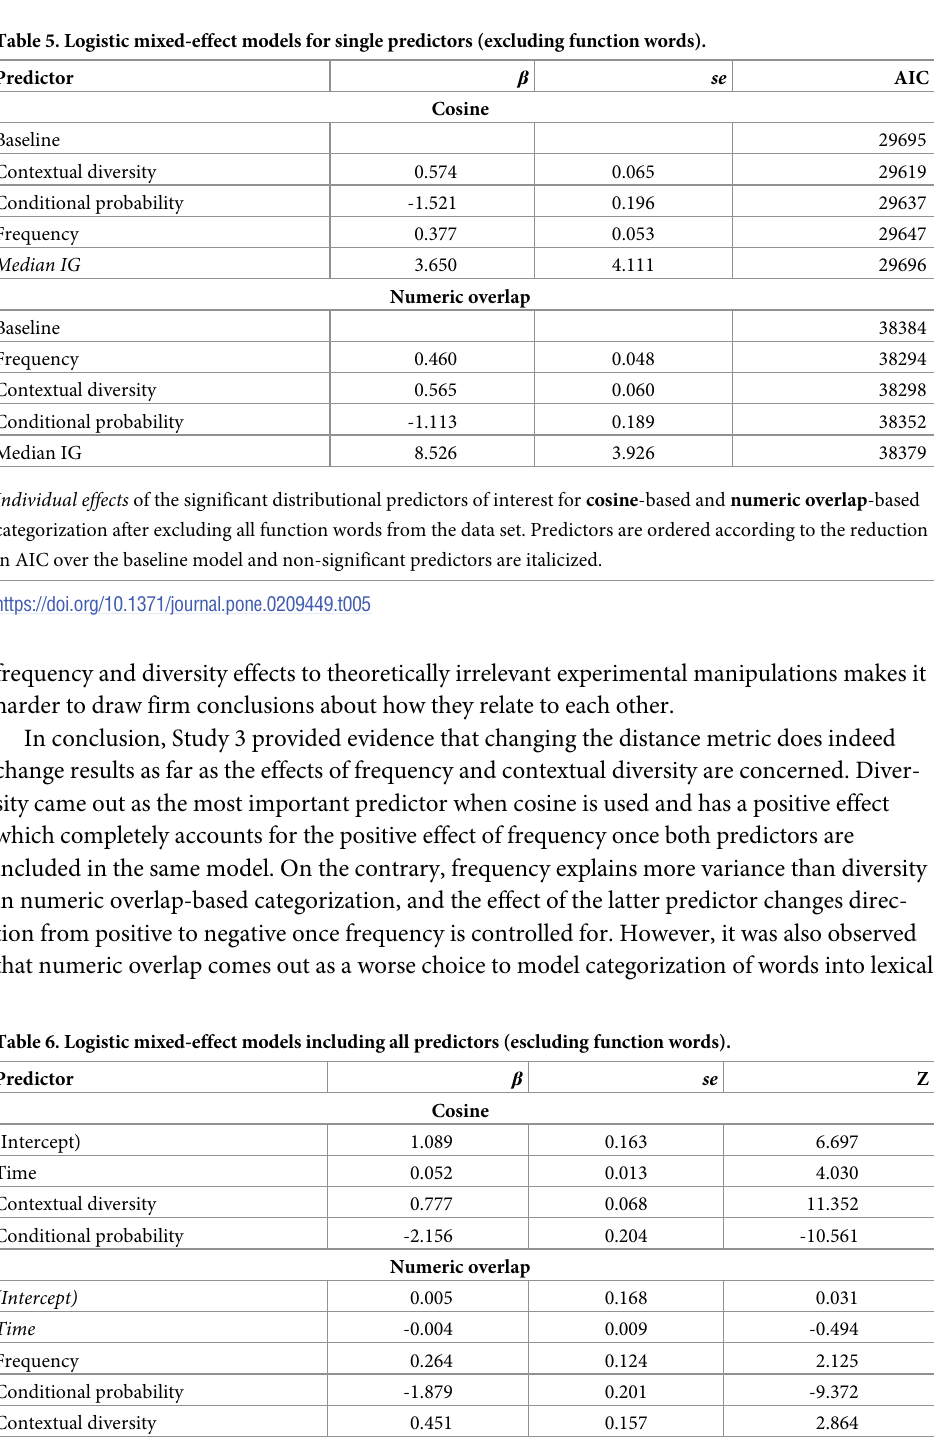
Effects of the significant distributional predictors of interest for cosine -based and numeric overlap -based categorization after excluding all function words from the data set when inputted in the same statistical model. Predictors are ordered according to the reduction in AIC brought over the simpler model. Predictors reported in italic are not significant, while all the others are significant at p <